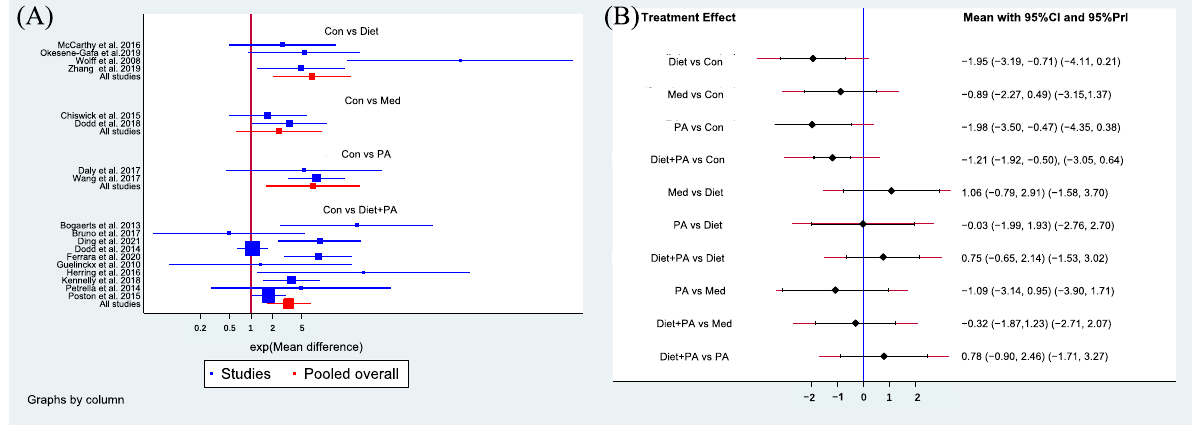
Figure 5. Network forest plot of direct pairwise comparisons of regimens ( A ), and of both direct and indirect comparisons of regimens ( B ) on GWG. Abbreviations: physical activity, PA; control, Con; medication, Med [5,8,13–17,21,23–25,29,31–34,36].